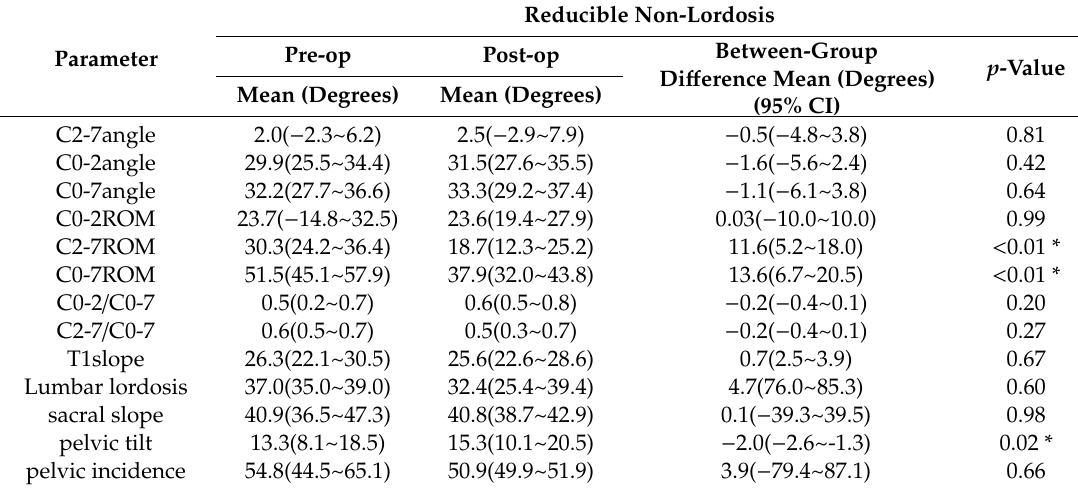
Table 7. Comparison of pre-operative vs. post-operative radiological parameters of the reducible non-lordosis